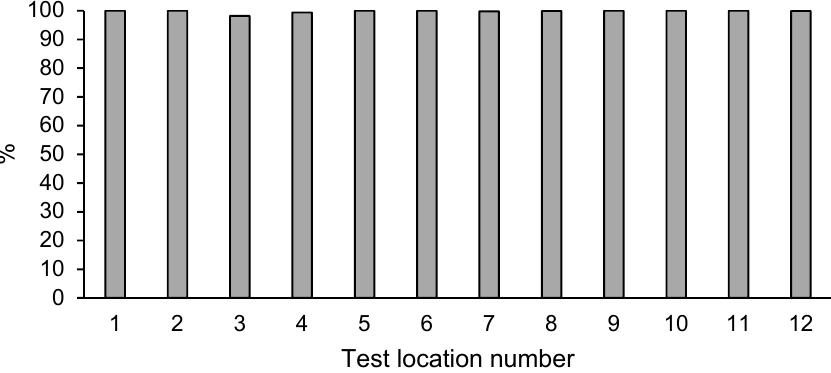
Figure 2. Percentage decrease of phenol content in the soil after enhanced natural attenuation.